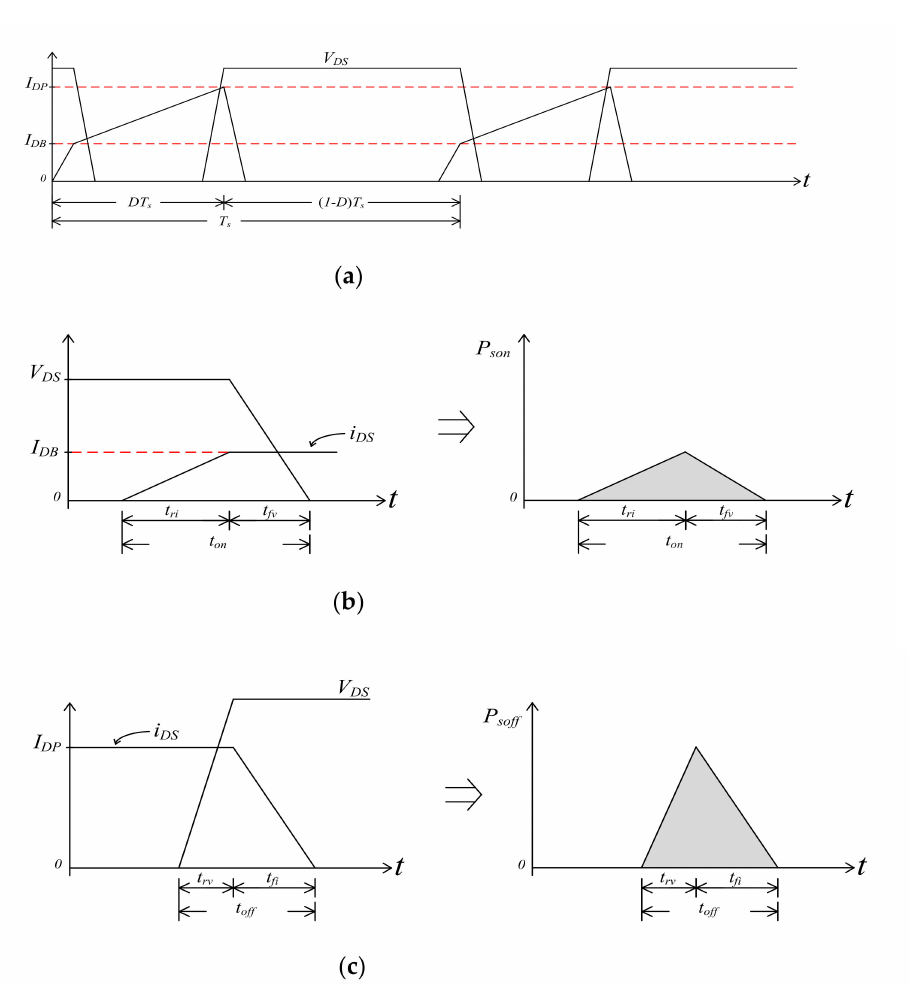
Figure 14. Conceptual waveforms of switching loss during switch turn-on and turn-off transitions ( a ) during one switching cycle, ( b ) during turn-on transition ( c ) during turn-off transition. (2). Loss of